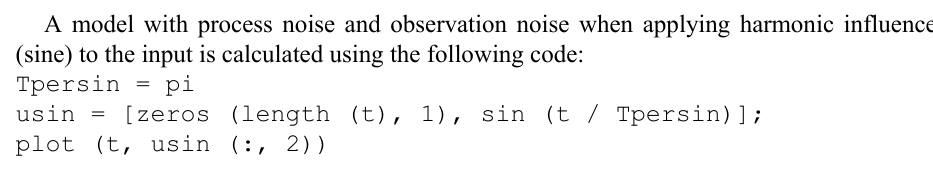
Fig. 7 . Simulation result with process noise and observation noise